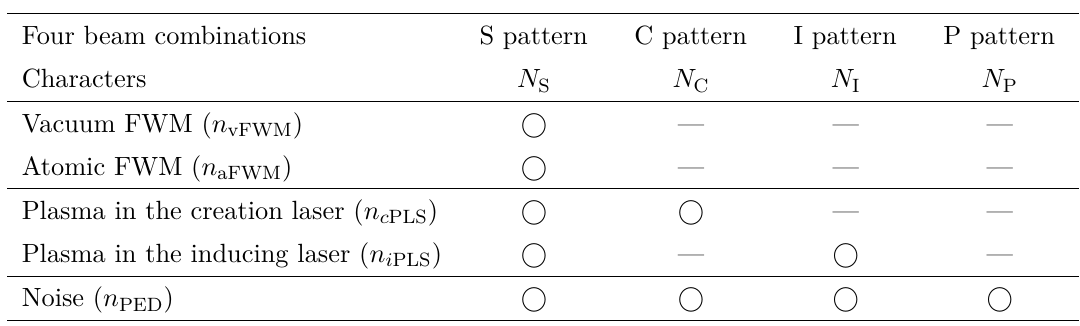
Table 1 . Sources of photons included in individual beam combination patterns. The characters N S , C , I , P denote the numbers of observed photons in the individual combination patterns expressed by the subscripts.